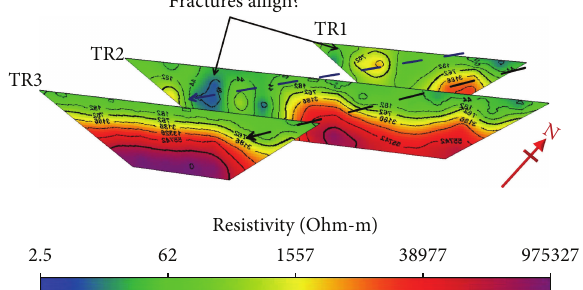
Figure 7: 3D composite fence plot from inverted 2D resistivity structures of the Uneme-Nekhua fracture zone (refer to Figure 1 for actual spatial distances between traverses). Fracture locations along TR1 and TR2 and basement trenches on all traverses are seen to align. The fractures likely are continuous in the subsurface with the exception of the location of TR3 downstream. Blue and black dashed arrow headed lines indicate aligned fracture and basement trench trends. These are essential conduits for groundwater migration within the